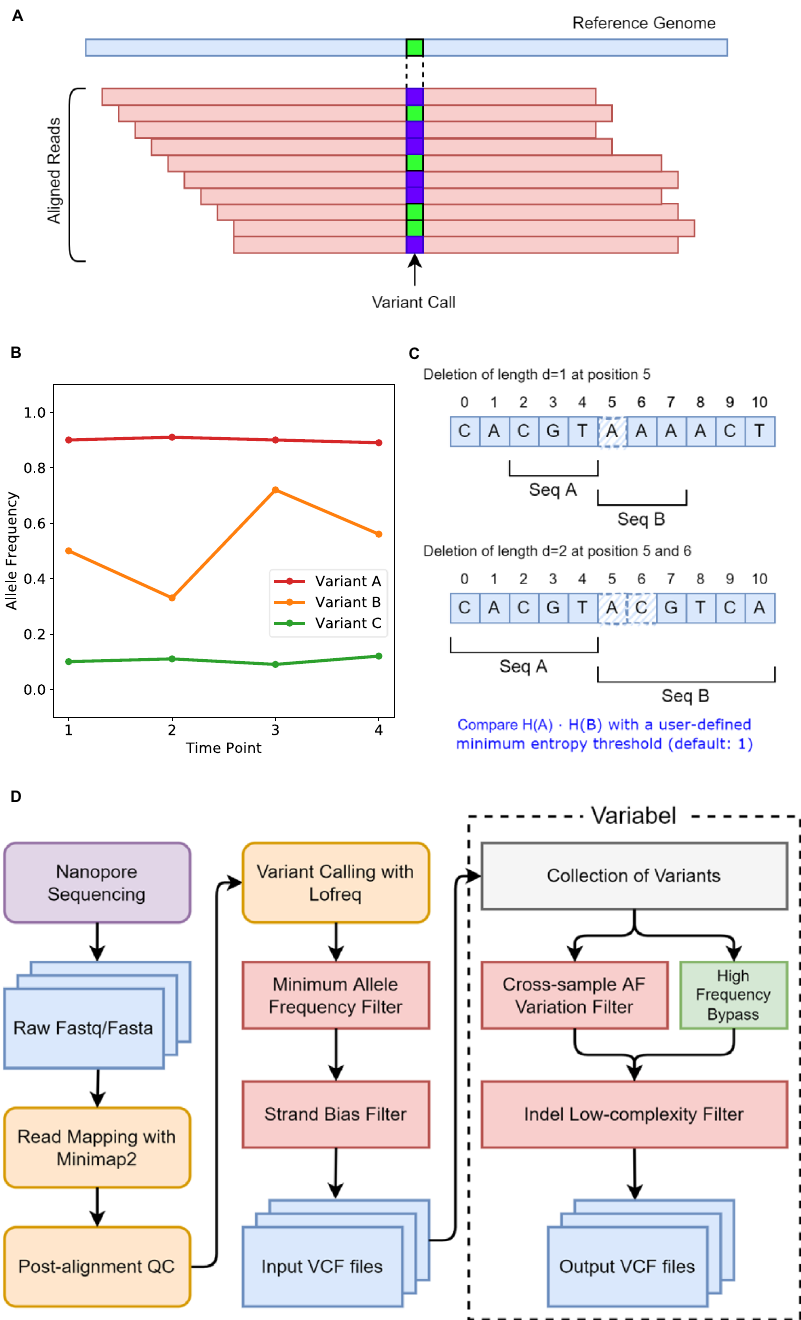
Fig. 1 Illustration of Variabel algorithm and work fl ow. A Sequencing reads from ONT are aligned to the reference genome of SARS-CoV-2 with Minimap2, then variants are called based on the alignments using LoFreq. The fi gure shows 4 reference supporting (green) reads and 5 alternative supporting reads (blue) amounting to an overall of 55.6% allele frequency within this sample. B Cross-sample AF variation fi lter identi fi es variants that are shared between samples. Variant calls with maximum AF less 0.65 and maximum AF variation less than 0.05 are classi fi ed as false calls. In this example, variant A and B pass the fi lter while variant C fails. C Low-entropy fi lter calculates the Shannon ’ s entropy H for subsequences (Seq A and B) of the reference genome around the position where the indel call occurs. The length of the subsequences is determined by the length of the indel. Product of two entropy of the subsequences is used to determine whether the indel is a false positive or not. D Work fl ow of Variabel for detecting intra-host variants for ONT Figure 3C shows precision, recall, and F-score for variant calls peak FP rate for Variabel occurs at allele frequency between 0.2 generated by different methods on both the time series and the and 0.25, which is associated with Nanopore sequencing errors. cross-patient datasets; shown are the LoFreq default output with Cumulative count plot of FP variant calls shows that Variabel has 0.02 minimum allele frequency fi lter, Variabel, and Clair3. For all a close to uniform distribution of false calls along different allele 18 samples that passed quality control from the time series frequencies. On the other hand, more than 70% of the FP calls dataset, applying Variabel resulted in a signi fi cant mean precision from Clair3 have allele frequencies less than 0.5.